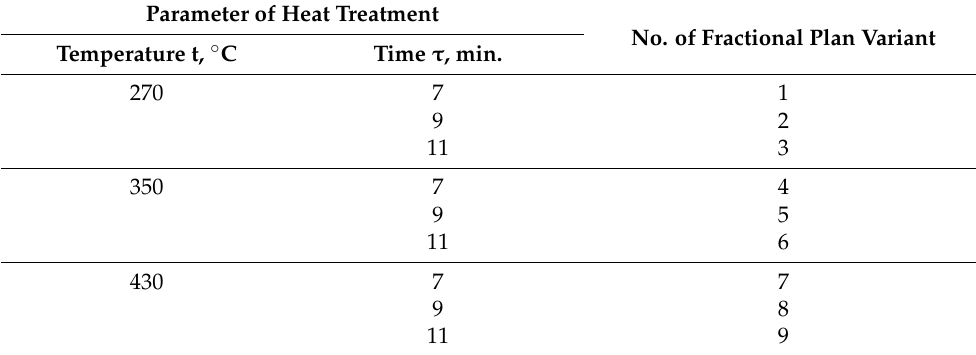
No. of Fractional Plan Variant